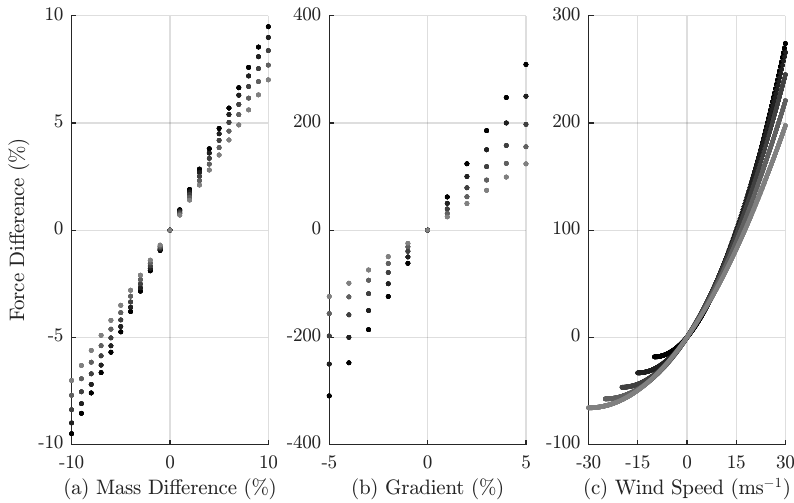
Figure 2. Vehicle model resistive force sensitivity to change in ( a ) mass; ( b ) gradient and ( c ) wind speed. The difference in total force resulting from a change from the default to the maximum and minimum of each variable is plotted for vehicle speeds from 10m · s − 1 to 30m · s − 1 . The range of values are +10– − 10% for mass, +5%– − 5% for gradient and maximum headwind to maximum tailwind of 30m · s − 1